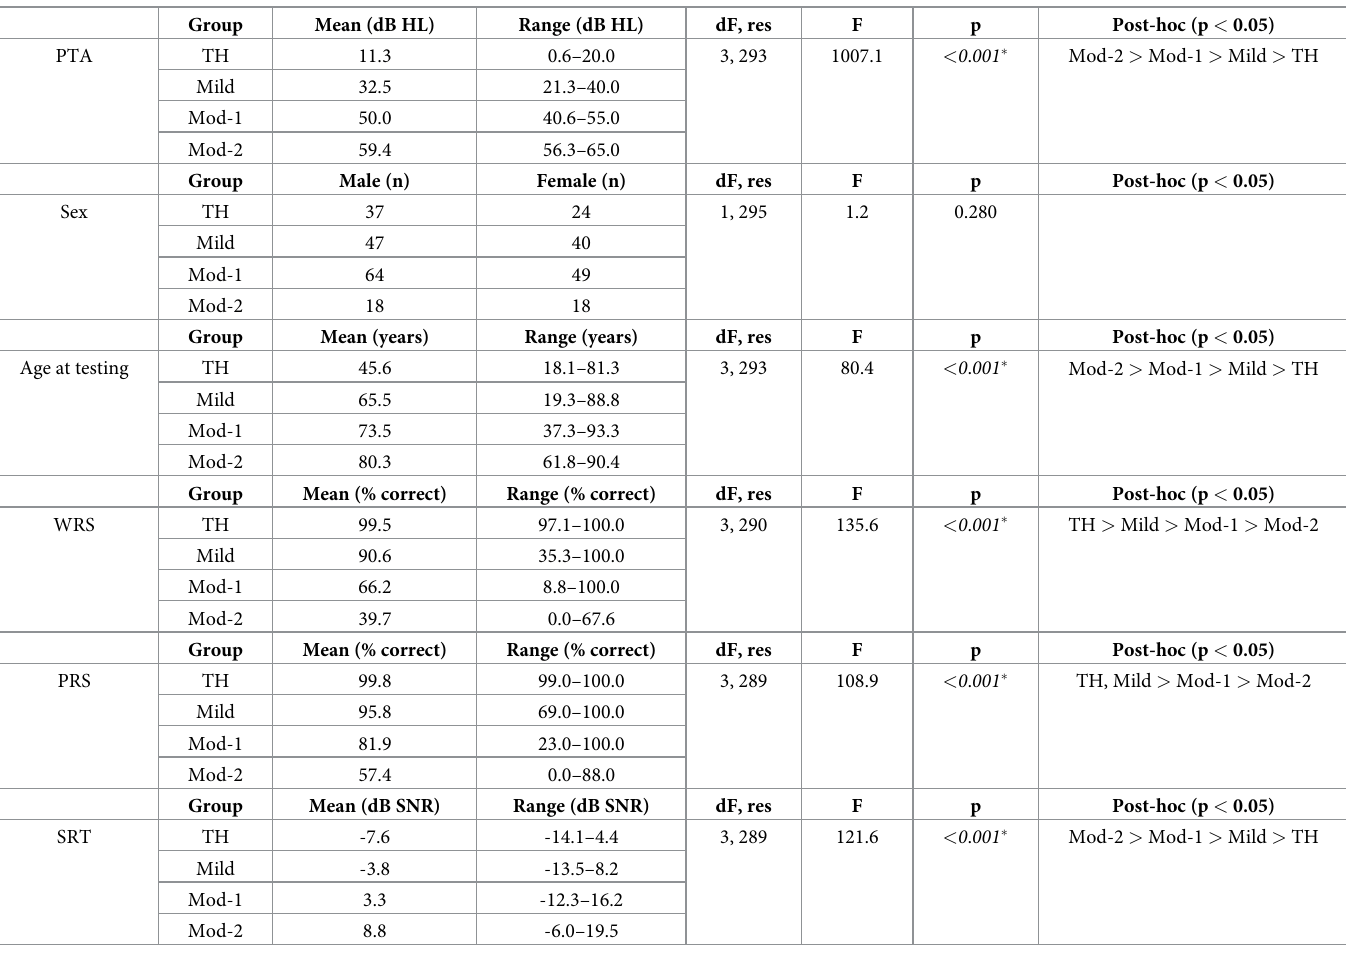
Table 2. Mean and range of PTA thresholds, age at testing, word recognition scores (WRS), phoneme recognition scores (PRS), and SRTs for the different hearing status groups. Sex data are also shown. Results from linear mixed-model analyses are shown at right. For the analyses, PTA thresholds, age at testing, word recognition scores, phoneme recognition scores, and SRTs were the dependent variables, hearing status group was the fixed factor, and participant was the random factor, except for sex, where sex was the dependent variable and participant was the random factor. Significant effects are indicated by asterisks and italics. Significant post-hoc Bonferroni- adjusted pairwise comparisons are shown at far right (p <